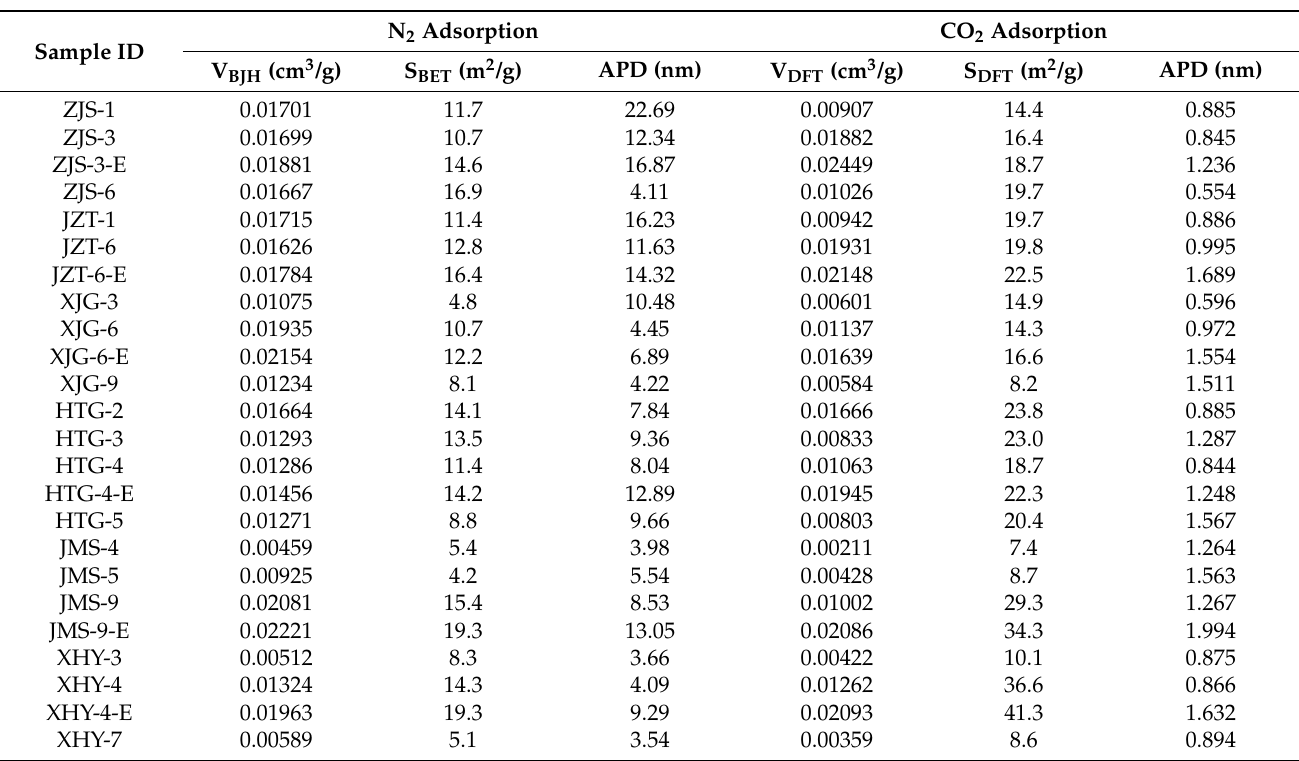
Table 3. Main pore structure parameters measured by low-pressure gas adsorption of the Mesoproterozoic Xiamaling shale in Zhangjiakou,